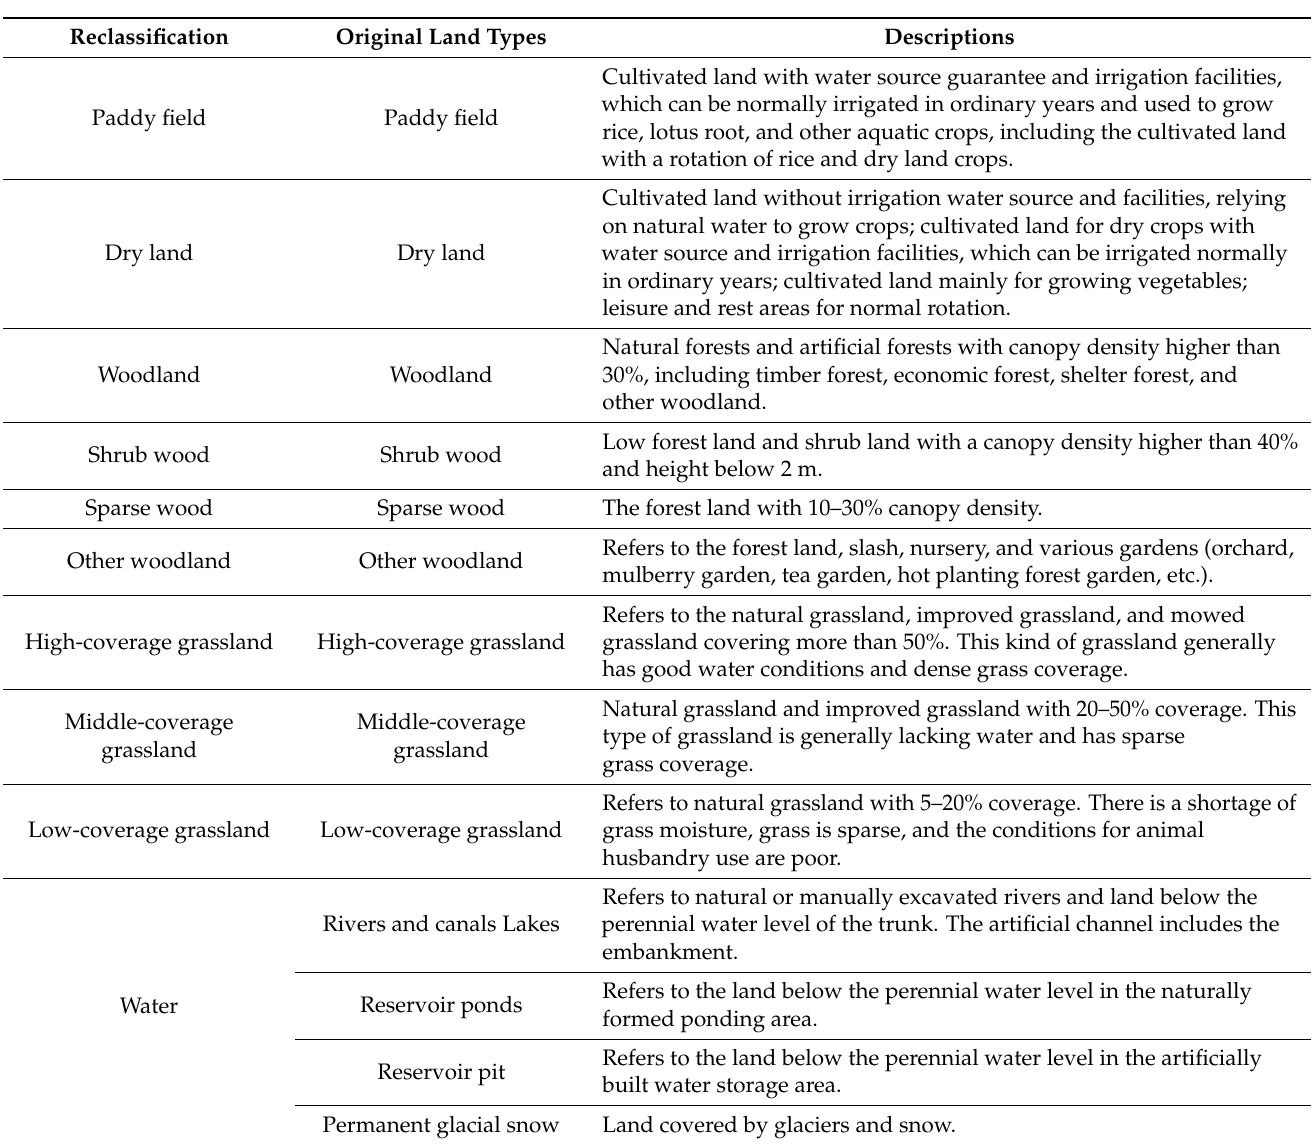
Table 2. Land use